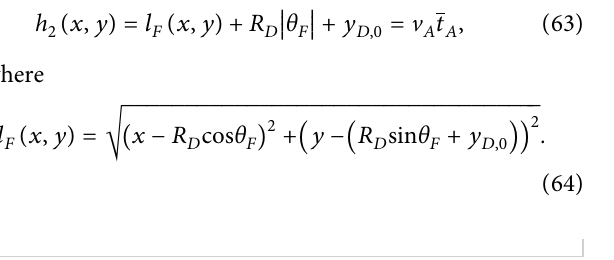
R ( 1 − α ) y R D, 0 ⩾ A and D, 0 < D